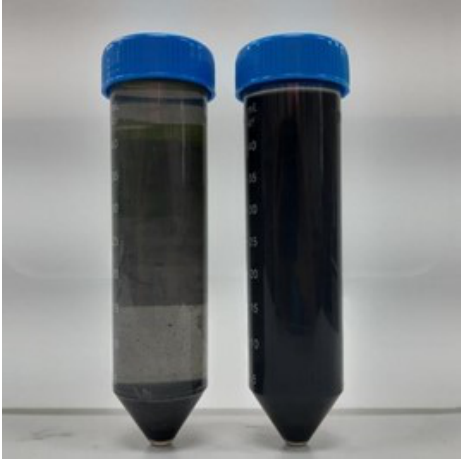
Fig. 1. Sample after centrifuge (left: after centrifuge; right: before centrifuge).